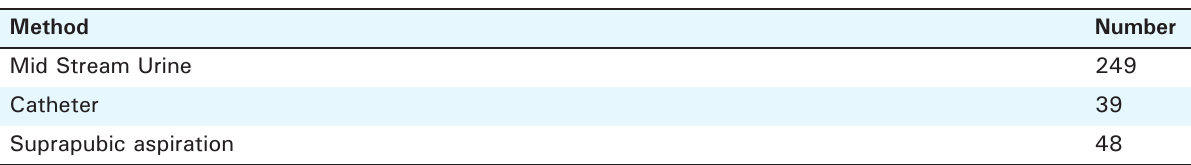
table 2. Method collection of urine specimenMethod collection of urine specimen